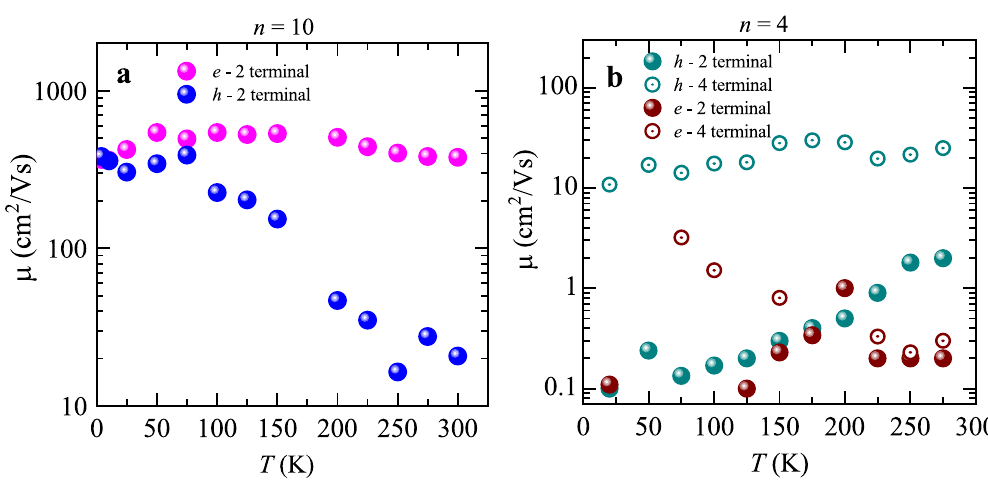
Figure 3. Electron- and hole- mobilities as a function of the temperature as extracted from the MOSFET transconductance formula for a ( a ) n = 10 and a ( b ) 4-layers thick sample. In ( a ) magenta and blue markers depict electron- and hole-mobilities respectively, as extracted from a two-terminal configuration under V ds = 50 mV. In ( b ) dark cyan and brown markers depict hole- and electron mobilities, respectively. Solid and open circles indicate mobilities extracted from two- and four-terminal configurations, respectively. The drain to source voltage applied to the 4 layer sample was V ds = 0.3